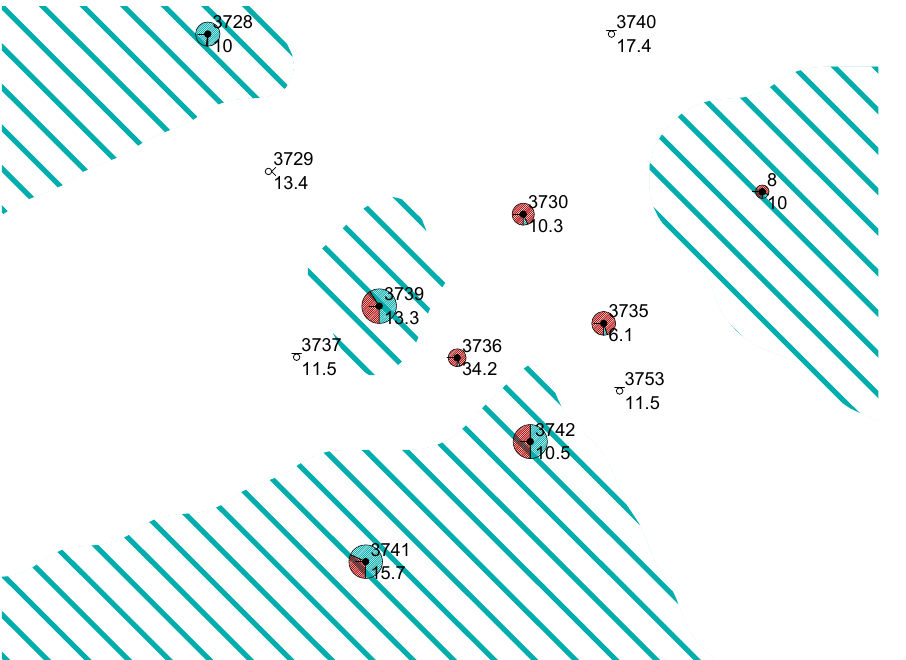
Figure 10. Plot Map of the well No. 3736 (Bashkirian Stage): The red part of the circle indicates the amount of oil produced, the green part – the amount of water produced and angled lines - water cutting of wells from reservoir pressure maintenance